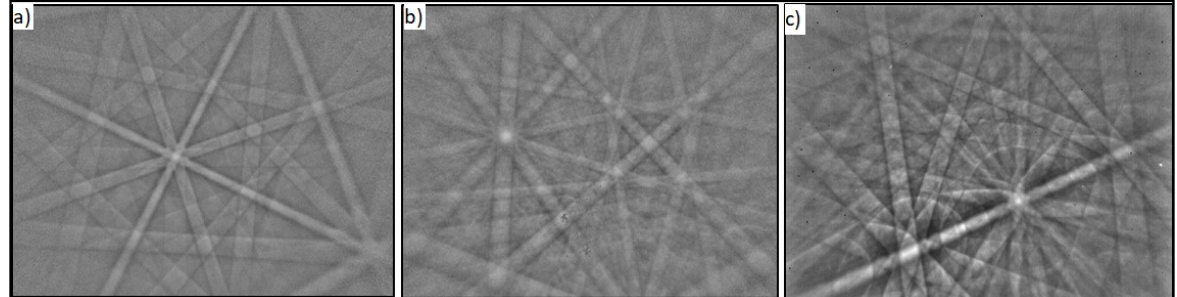
Figure 2. SEM image with the EBSD analysis of an NiTi-2 sample (0.5um scale): ( a ) NiTi cubic phase; ( b ) NiTi 2 cubic phase; ( c ) Ni 3 Ti hexagonal phase.